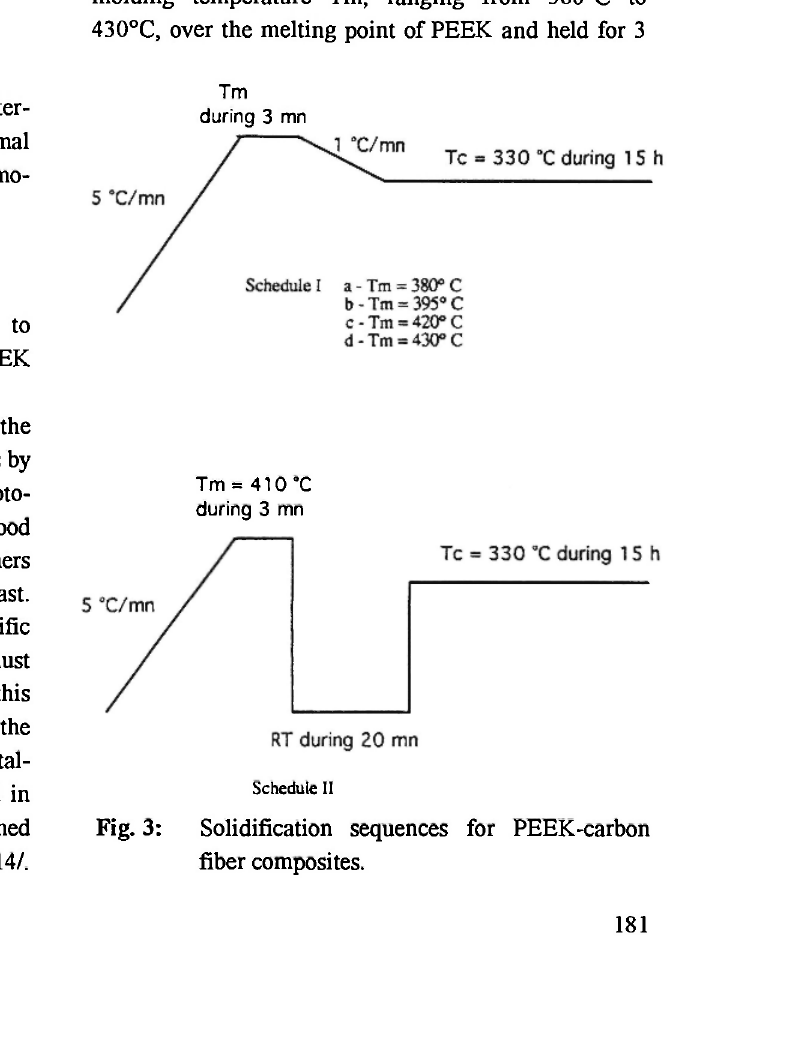
Fig. 3: Solidification sequences for PEEK-carbon fiber